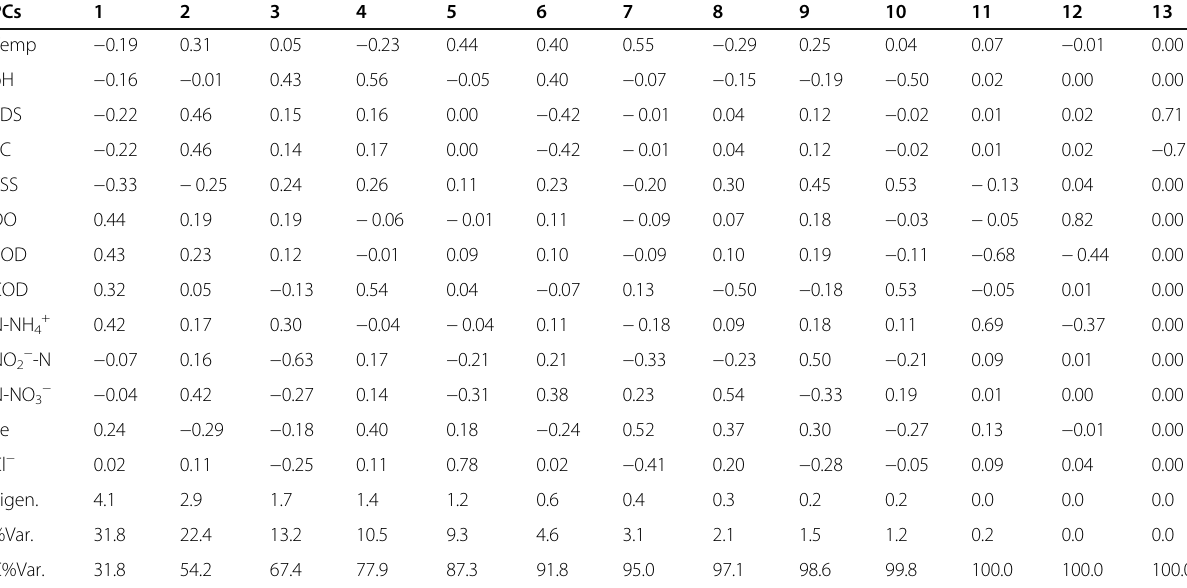
Table 5 Potential polluting sources and key water parameters influencing surface water